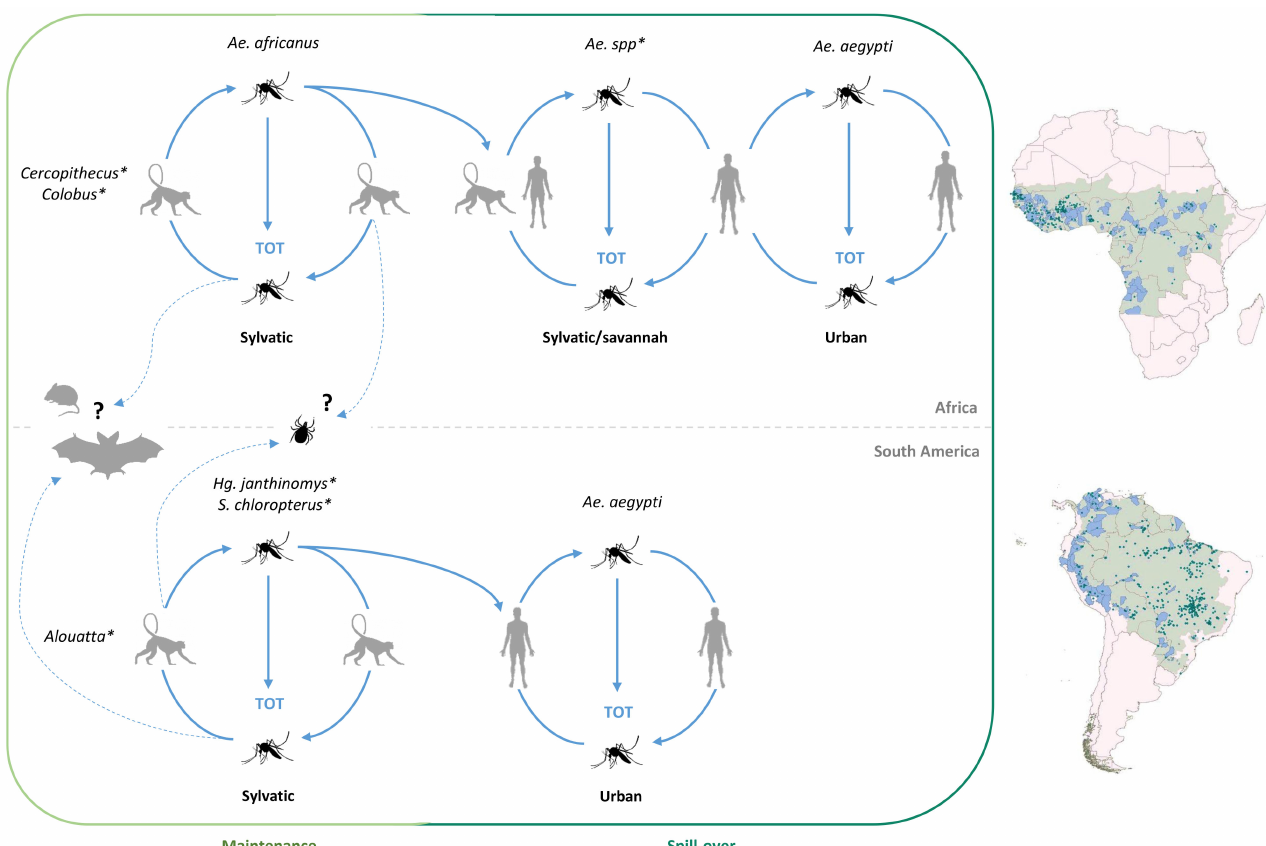
Figure 1. Ecology of Yellow Fever Virus (YFV) (modified from [51,52]). Areas with autochthonous vector-borne transmission are highlighted in pale green. A star indicates that the contributing vectors are detailed in the caption. Yellow fever virus maintenance in nature is thought to be ensured through a sylvatic cycle between its non-human primate (NHP) hosts and its sylvatic vectors in Africa and South America. Comprehensive lists of the African/South American arthropods for which YFV isolation and/or experimental transmission has been reported are provided in the Supplementary Table S1. In Africa, NHPs belong to the genera Cercopithecus , Colobus , and Galago